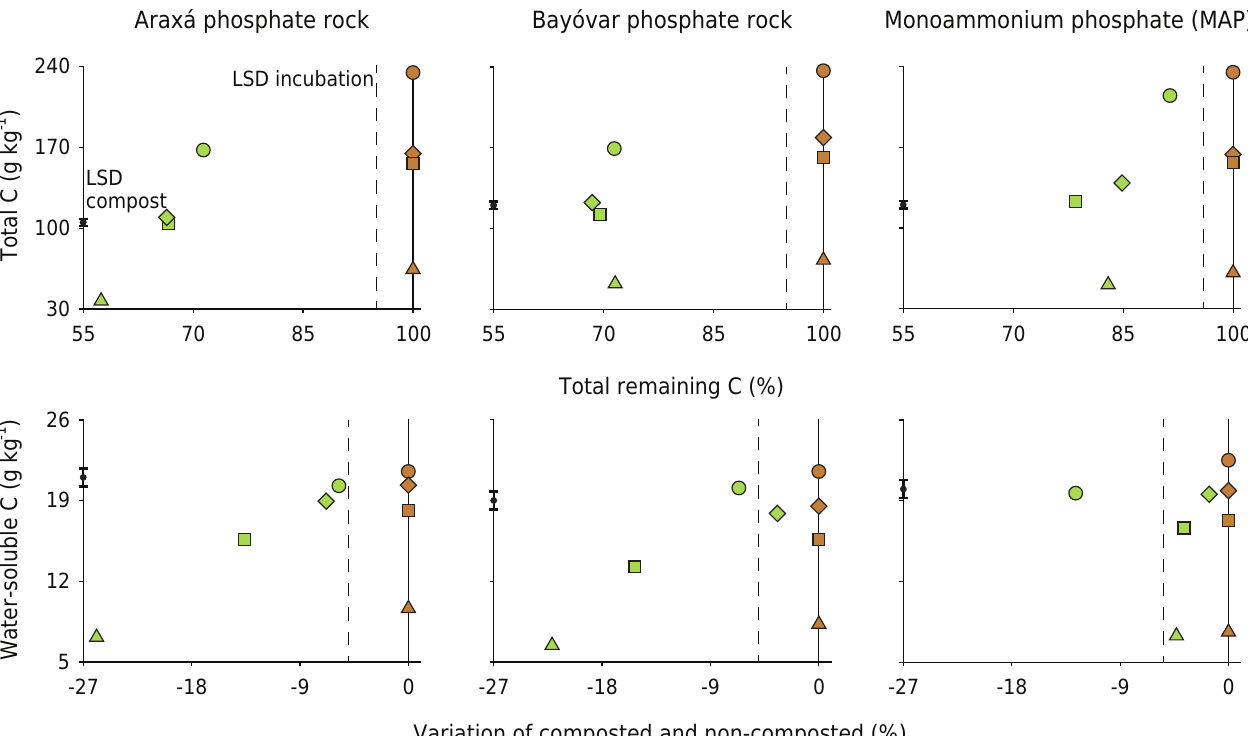
Table 3. Dry matter and N losses in mixtures with chicken manure, coffee husk, and Araxá phosphate rock (PR), Bayóvar PR, or monoammonium phosphate (MAP), after 150 days of composting Dry matter loss N loss Compost Araxá PR Bayóvar PR MAP Araxá PR Bayóvar PR MAP % % P25:CM37.5CH37.5